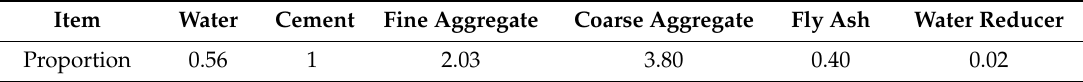
Table 1. Mixing proportions of concrete specimens.